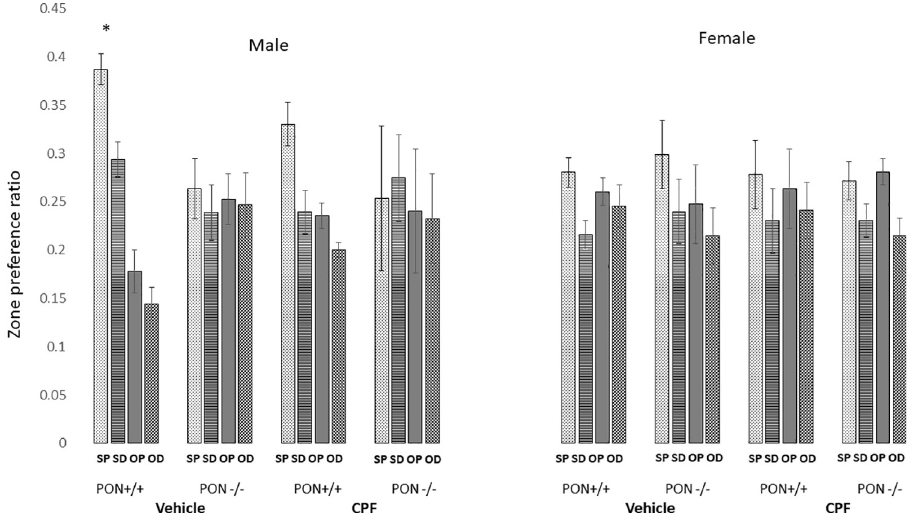
Fig 4. Mean + SEM preference for another conspecific. � p < 0.005 compared to each of the other zones. The number of mice per groups is in parentheses as follows: PON1 +/+ Males vehicle (10), males CPF (5), Females vehicle (10), females CPF (8), PON1 -/- Males vehicle (6), males CPF (5), Females vehicle (4), females CPF